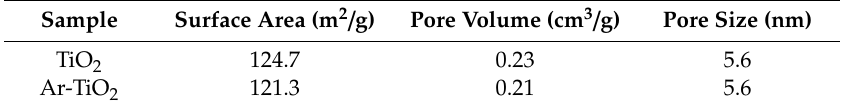
Table 2. BET specific surface are, pore volume and pore size of TiO 2 and Ar-TiO 2 catalysts, respectively.